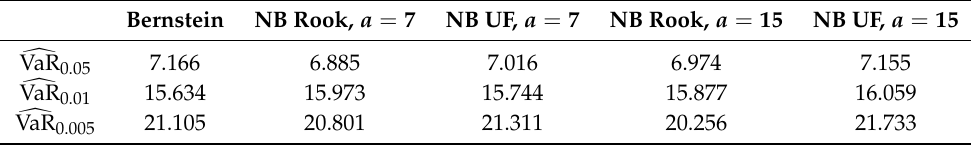
Table 4. VaR estimates with Bernstein and Negative Binomial copulas.